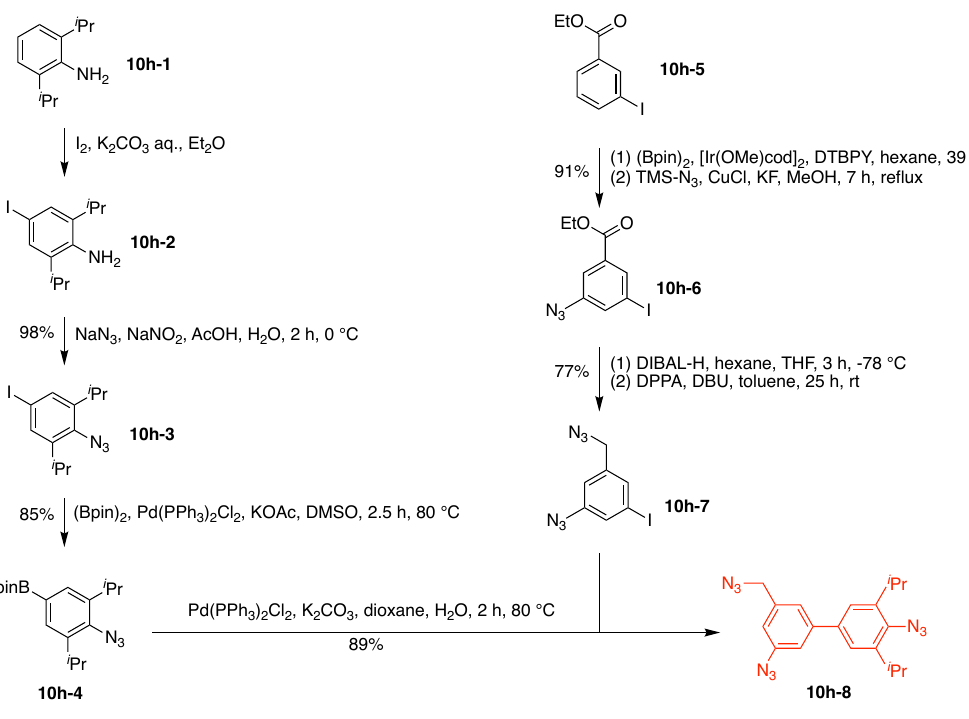
Figure 45. Synthesis of a triazido